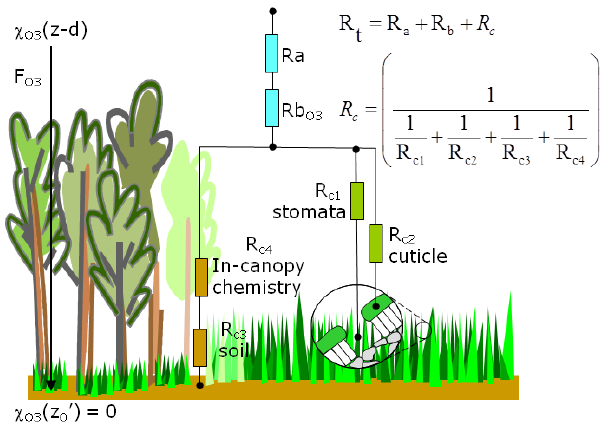
Figure 5. The resistance analogy for ozone deposition to vegetation and soil (for details of nomenclature see